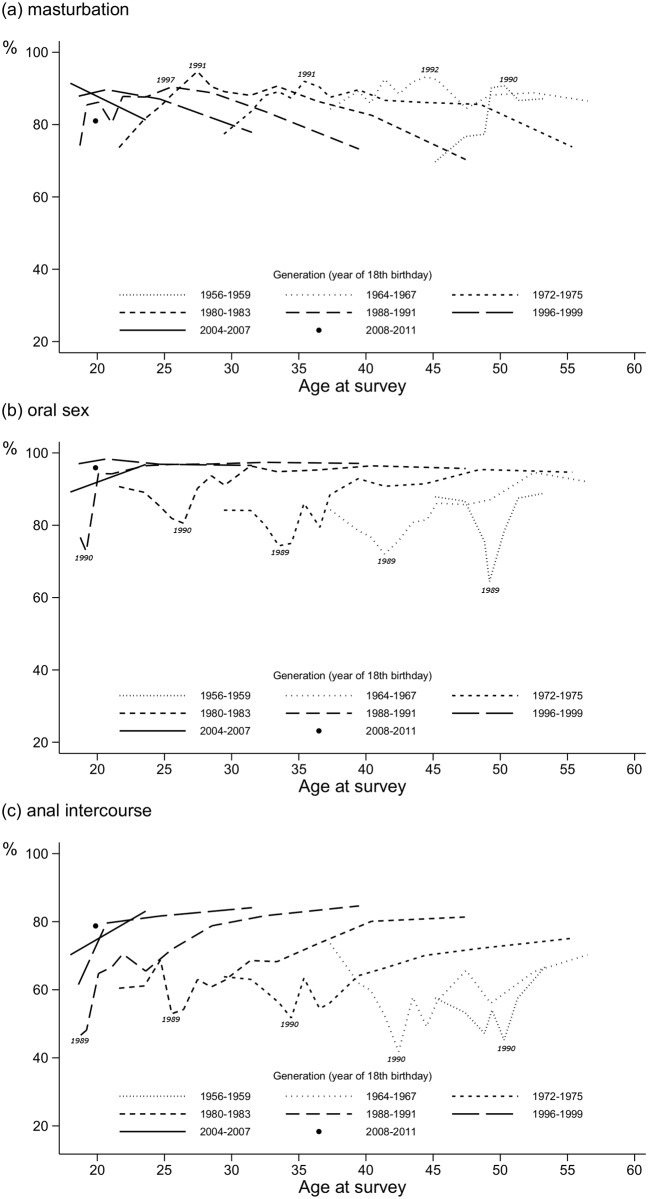
Percentage of participants reporting (a) masturbation, (b) oral sex, and (c) anal intercourse as frequent practices.Surveys in 1985–2011, respondents aged 18–59. Reading: 61.5% of the respondents from the 1996–1999 generation reported frequent anal intercourse when their mean aged was 18.6 years (i.e., when they were surveyed in 1997).Lines are drawn only when the generation is composed of at least 30 respondents.